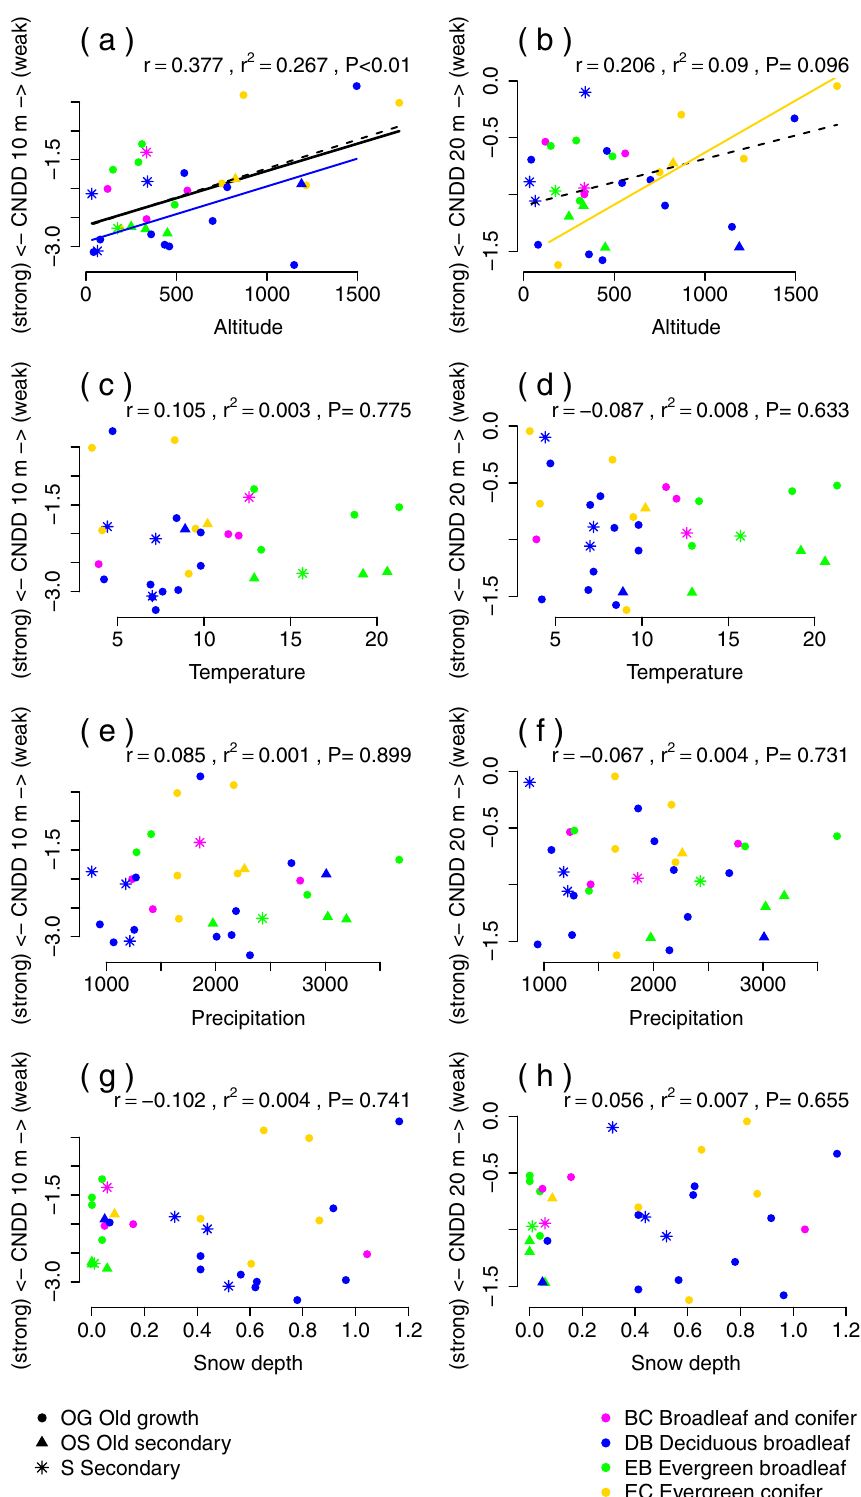
Figure 2. Correlations of conspecific negative density dependence (CNDD) with environmental characteristics for 10 m ( a , c , e , g ) and 20 m ( b , d , f , h ) spatial scales. Coloured points correspond to four forest functional types and point characters classify forests according succession stage. Coloured lines are shown if there was a significant linear correlation (P ≤ 0.05) inside the forest type, except black line that corresponds to an overall correlation without considering the forest types and succession stages. Solid lines are used for correlations of all forest succession stages and dashed lines represent correlation limited to old growth forests. Forest types are shown by colours: evergreen broad-leaved, deciduous broad-leaved, broad- leaved and conifer, and evergreen conifer. r is Spearman correlation coefficient, P is significance and r 2 is a fraction of variance explained by the linear model of overall correlation (all types and succession stages of